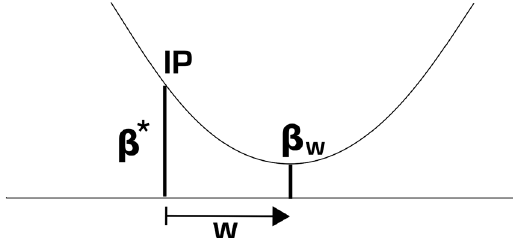
FIG. 3. The minimum of the β function is β w and it is displaced longitudinally away from the IP a distance w . The β function grows quadratically away from the waist. w is defined as positive when the waist lies downstream from the